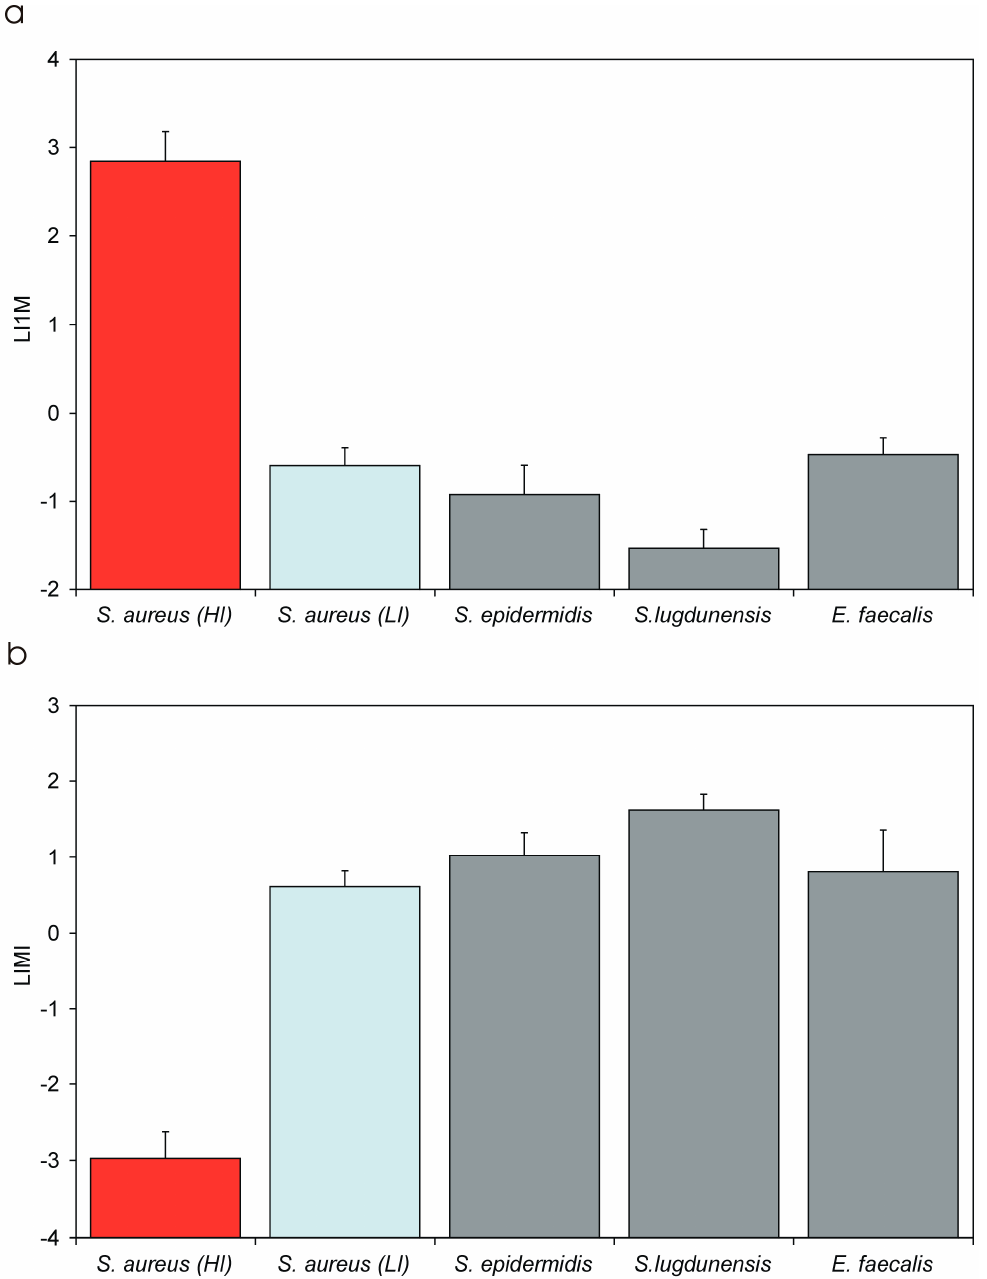
Figure 8. LI1M ( a ); and LIMI ( b ) values across the different microbial species investigated. Bars represent mean values ± S.D.